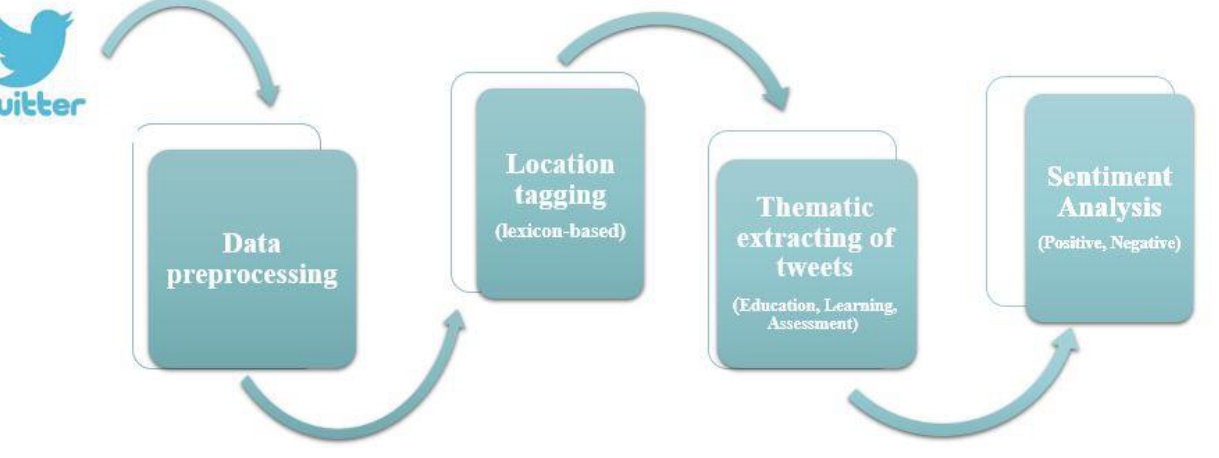
Figure 1. Proposed method.